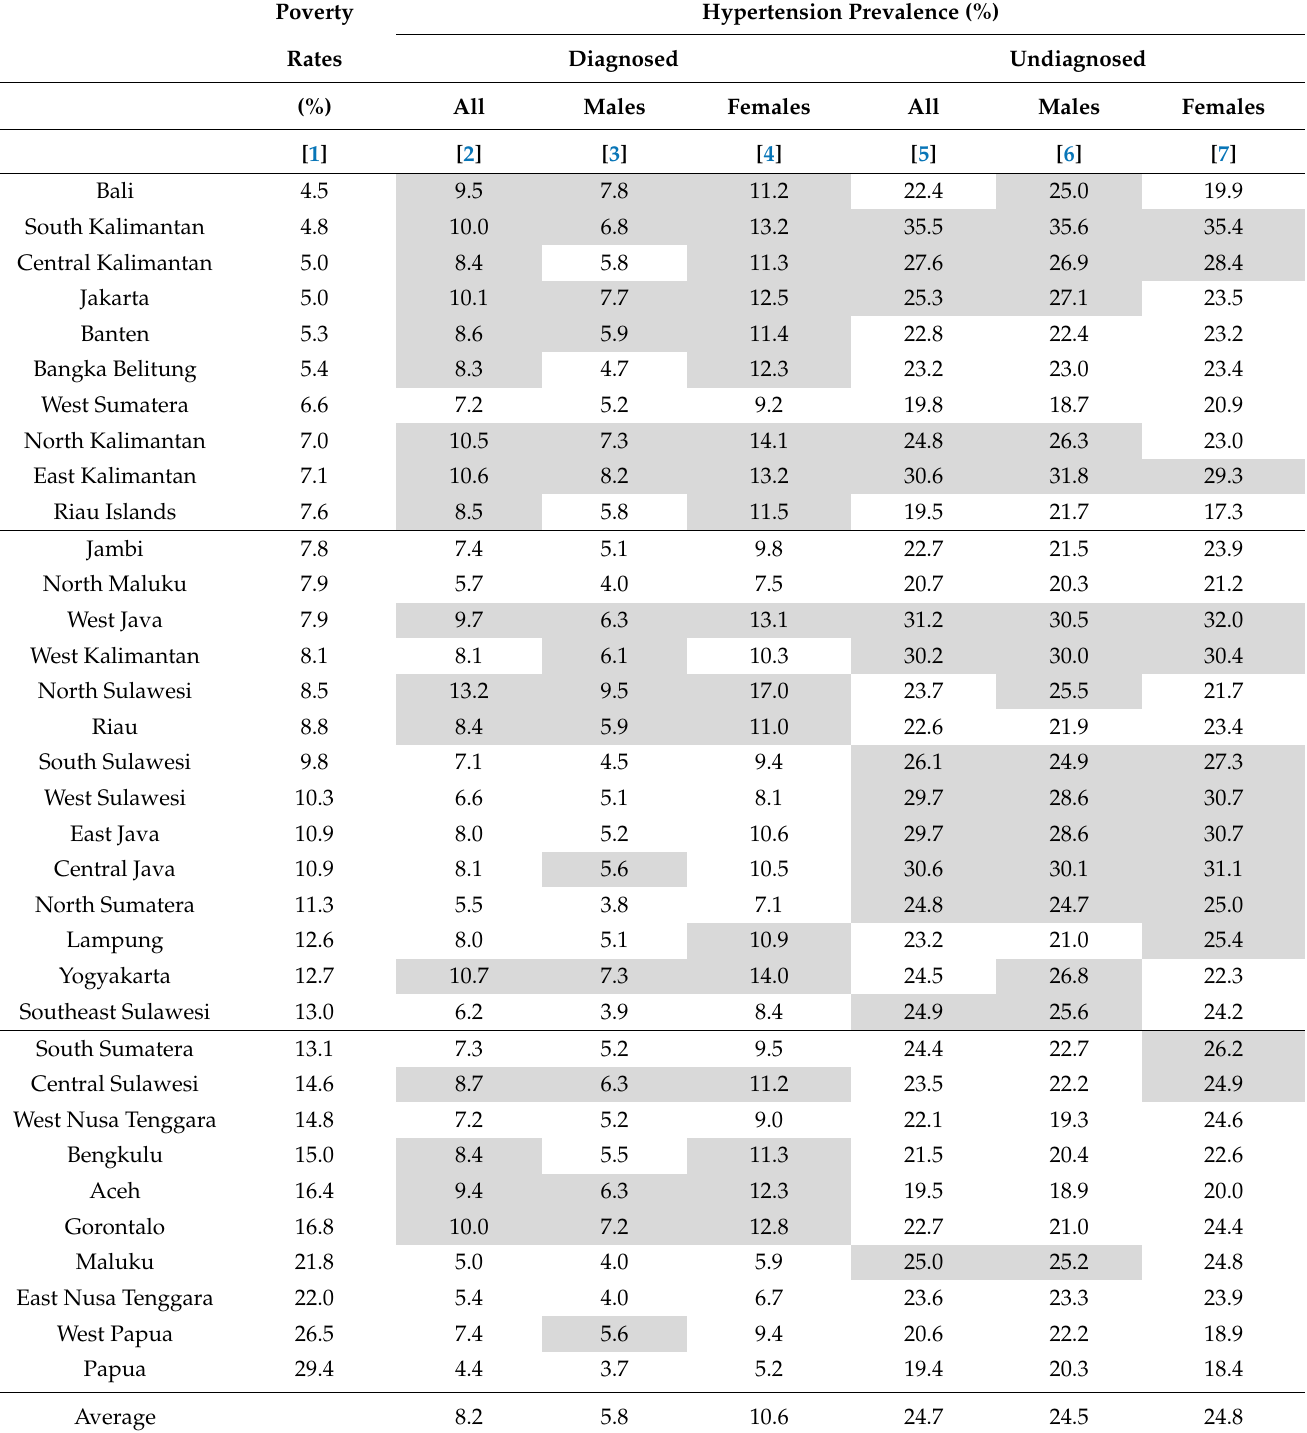
Table 1. Prevalence of diagnosed and undiagnosed hypertension among adults (18+ years) by province in Indonesia,